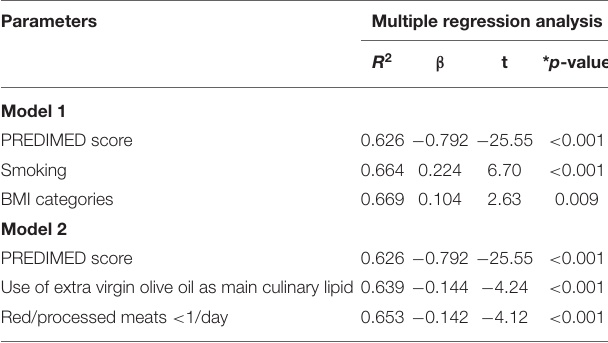
TABLE 10 | Multiple regression analysis models (stepwise method) with the thyroid nodules presence/absence as a dependent variable to estimate the predictive value of sex, lifestyle characteristics, BMI categories, PREDIMED scores, and each item included in PREDIMED questionnaire. Parameters